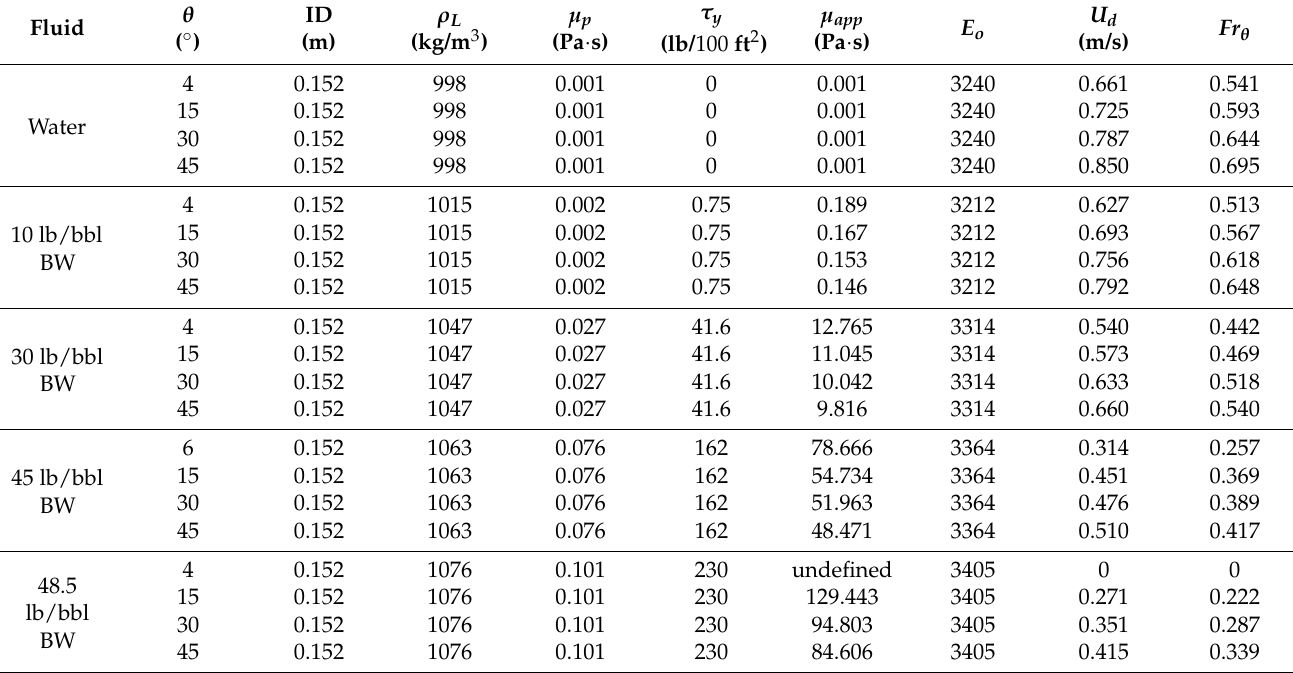
Table A1. Experimental Taylor bubble drift velocity data in inclined